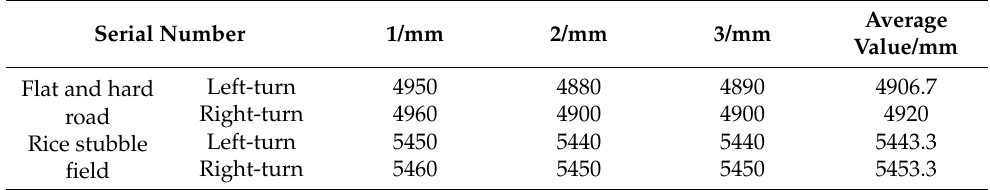
Figure 20. Climbing test.